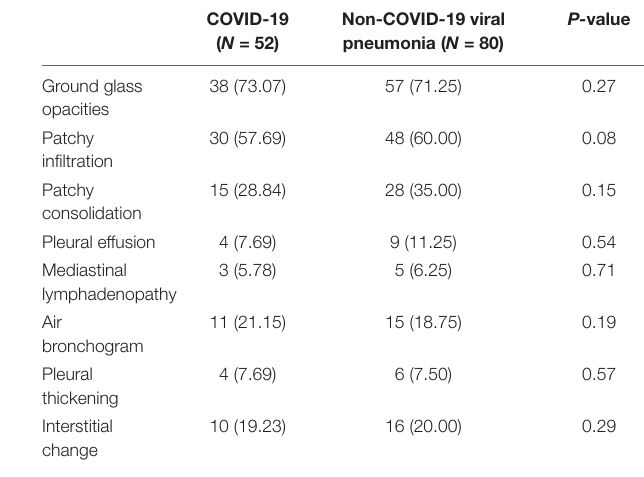
TABLE 2 | Radiologist interpretation of chest CT before NAT results [ n